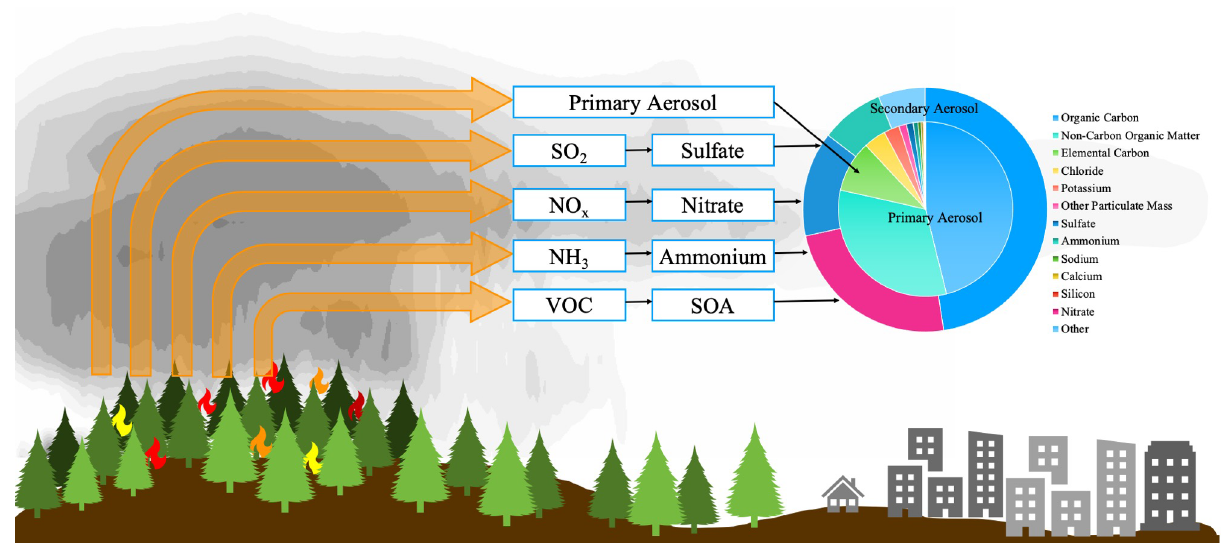
Figure 2. Wildfire primary emissions and downwind evolution. Note that the percentage for primary aerosols is from the CMAQ biomass burning input file. The percentage for the secondary aerosols is not real; it is just for illustration purposes. Moreover, the CMAQ model separates organic carbon (OC) and non-carbon elements (O, H, etc.) in organic matter